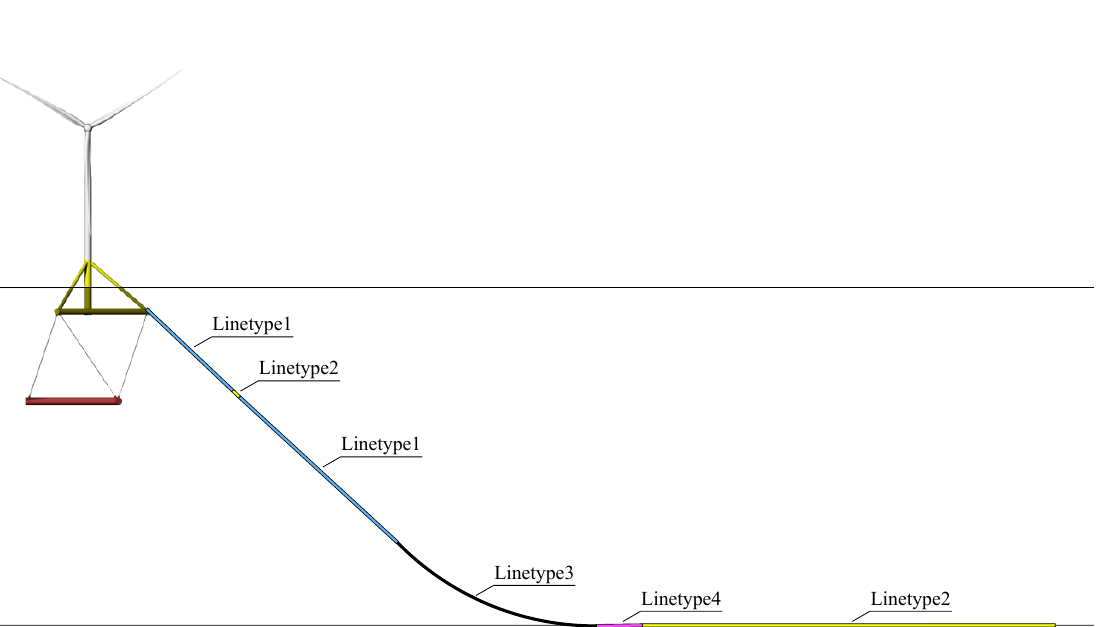
Figure 6. Mooring segments